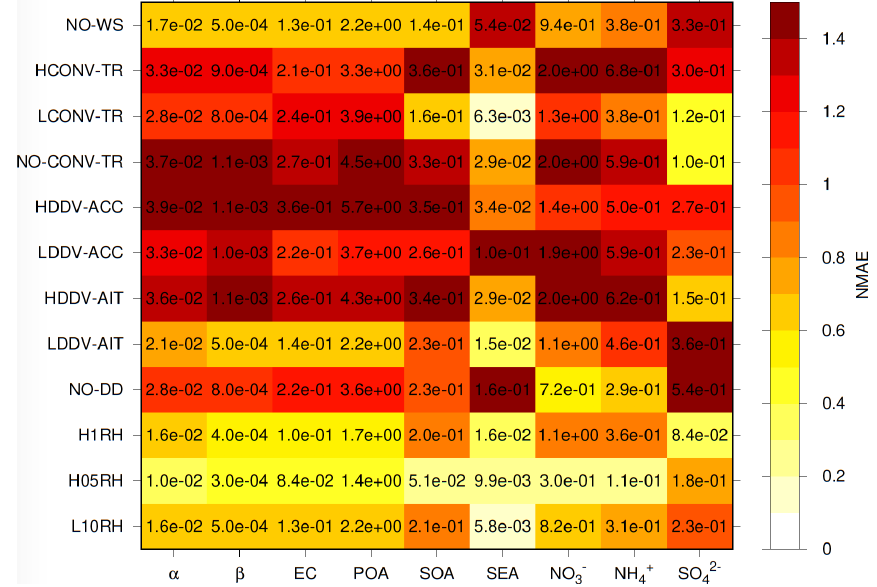
Figure 4. Normalized absolute differences (colour) and absolute differences (numbers) between each experiment and the base case over the MAX-AOD location. Columns represent each variable and rows each